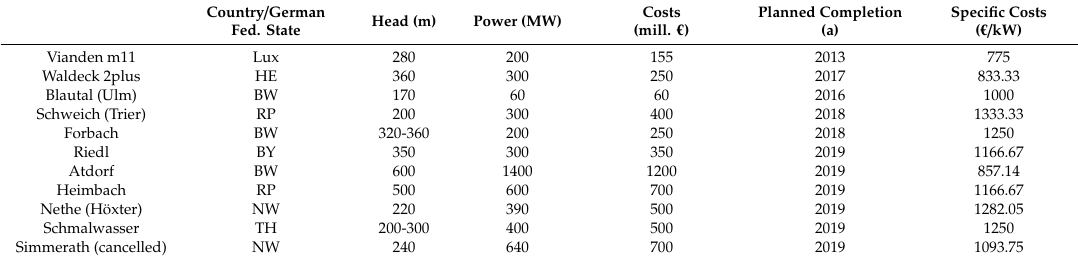
Table 2. PHS projects in